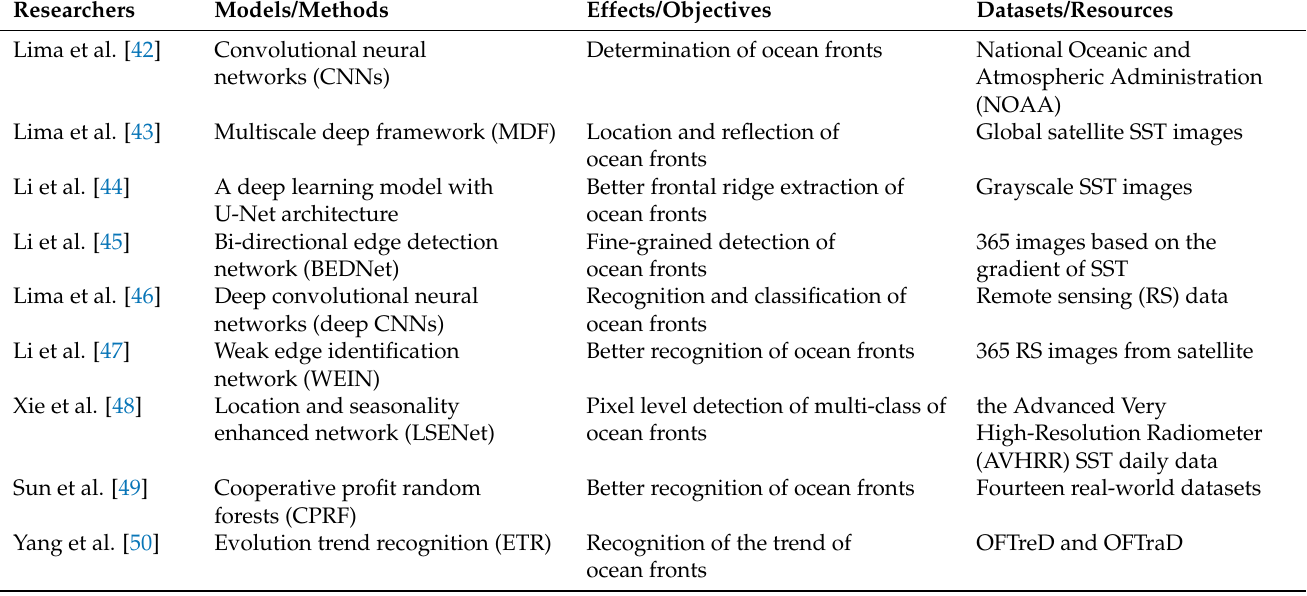
Table 1. Use of artificial intelligence methods to detect ocean